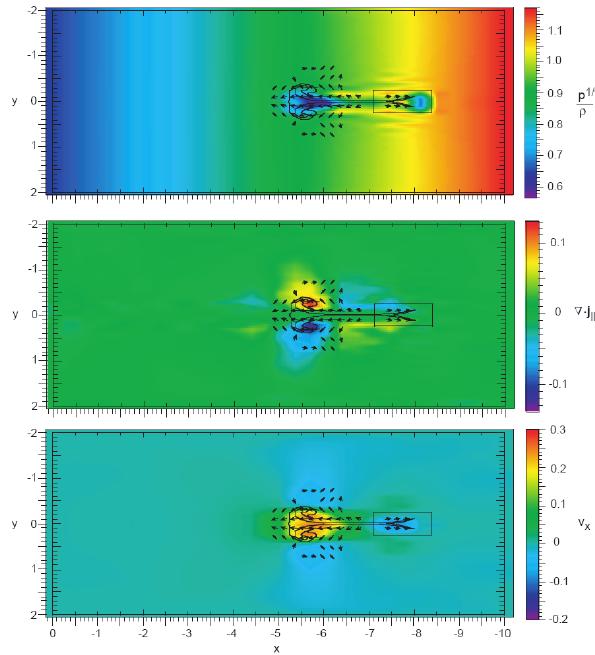
Fig. 39. Schematic of a plasma bubble. The upper panel emphasizes the plasma flows inside the bubble (including the field-aligned flow bringing to the temporary pressure increase in the bubble horn). Lower panel illustrates the distribution of flows (red arrows), E-field (magenta) and magnetic shear corresponding to the field-aligned currents at the bubble flanks. (From Birn et al., 2004).